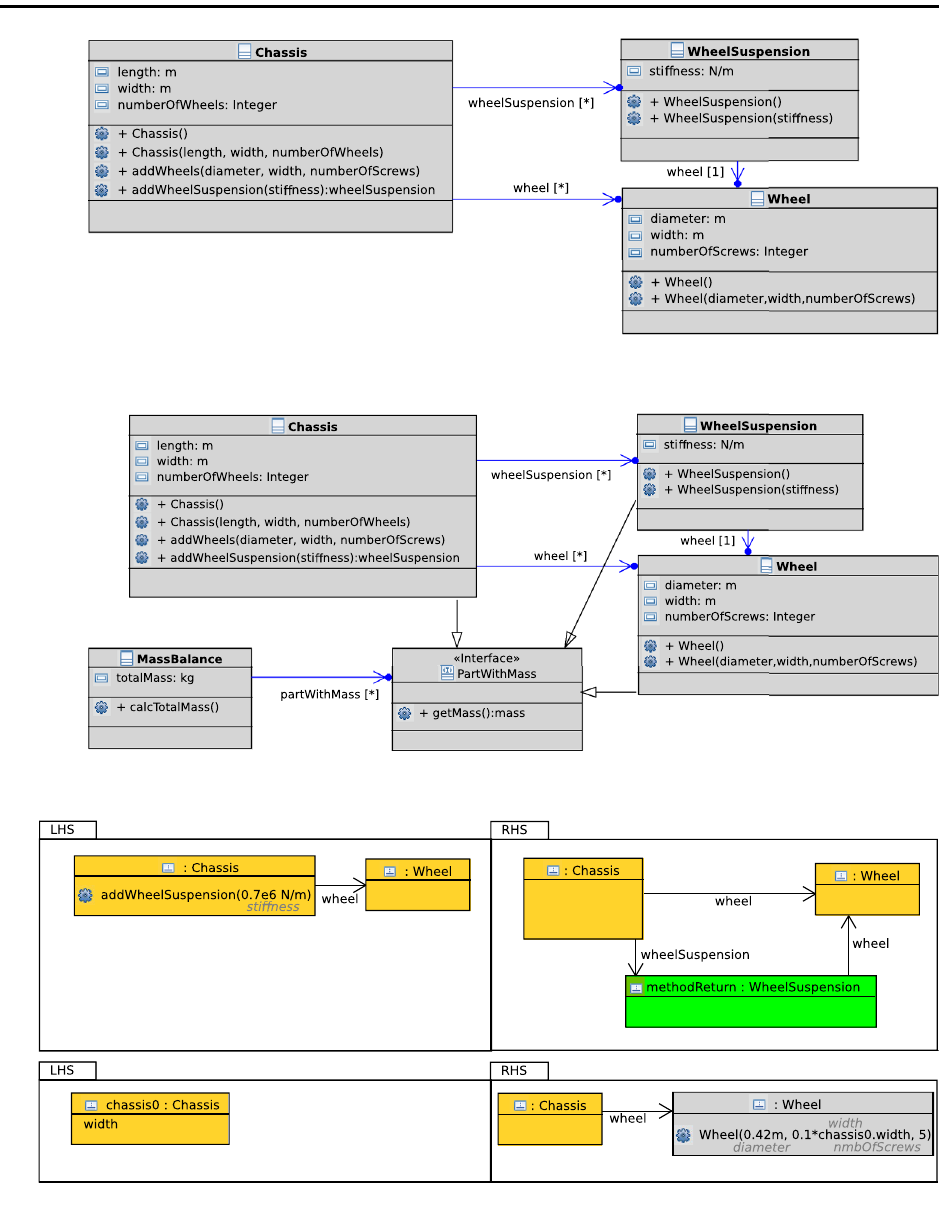
Fig. 6 Extended class diagram with object-oriented class methods and class construc- tors (compare with ‘classi- cal’ class diagram in Fig. 3 that lacks the methods and constructors). The data types of the methods’ parameters are not shown for the sake of simplicity. This applies to all